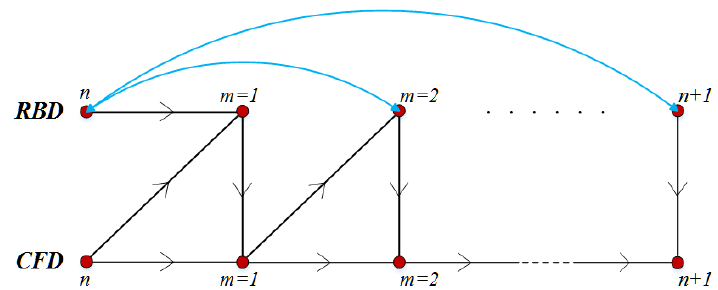
Figure 3. Sketch of data exchanges in fully implicit coupling computation.